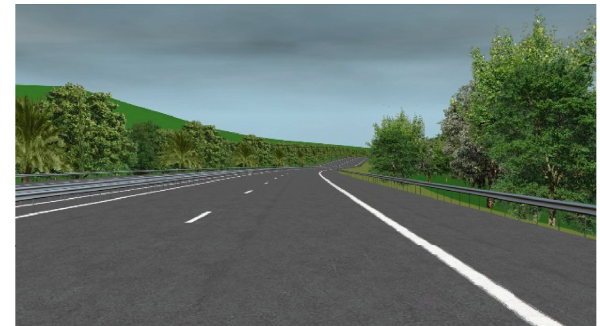
Figure 9: Model layer of road